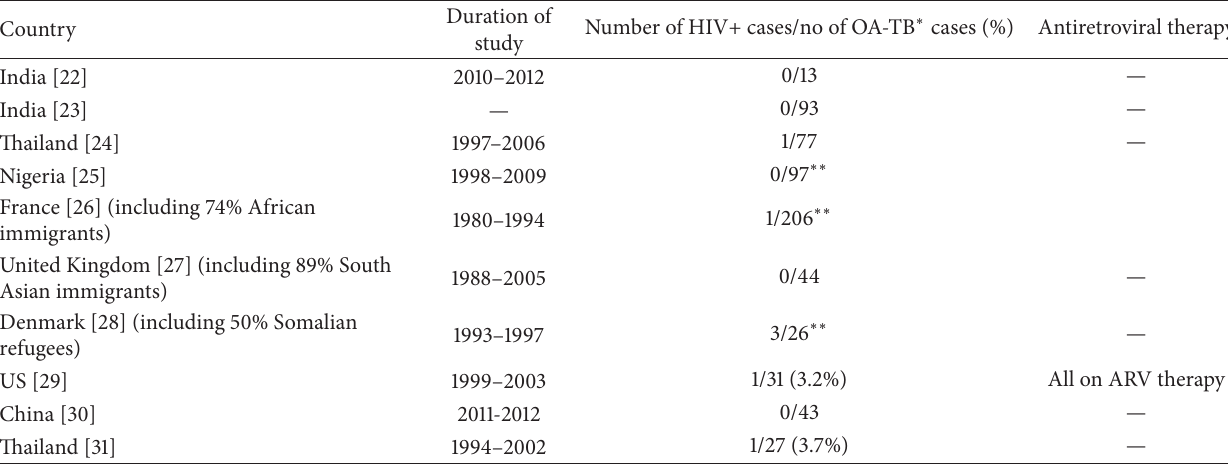
Table 1: Case series of osteoarticular TB with HIV